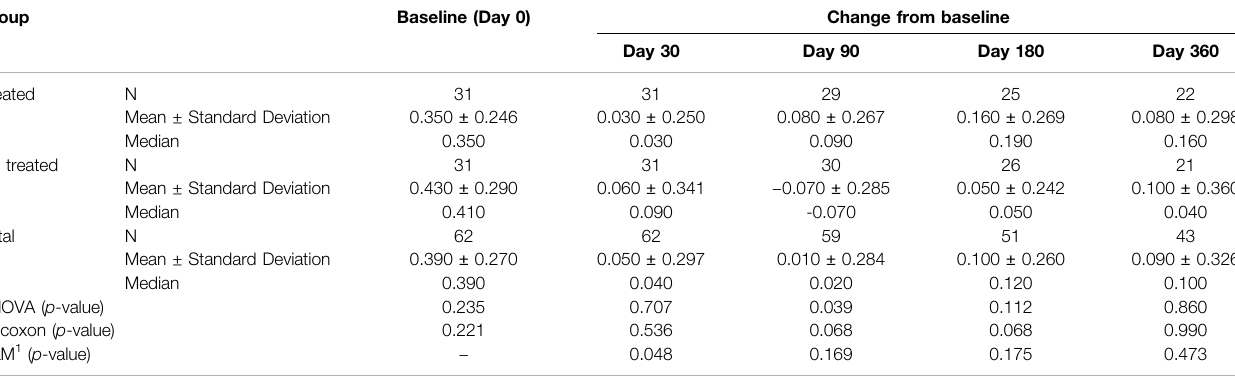
TABLE 3B| (part2of4). GAITparametersfullcohort. PeakKneeValgus-VarusMoment. GeneralLinearModelwithPeakKnee Valgus-Varus Moment changefrombaseline as dependent variable, treatment as factor, and Peak Knee Valgus-Varus Moment baseline value as